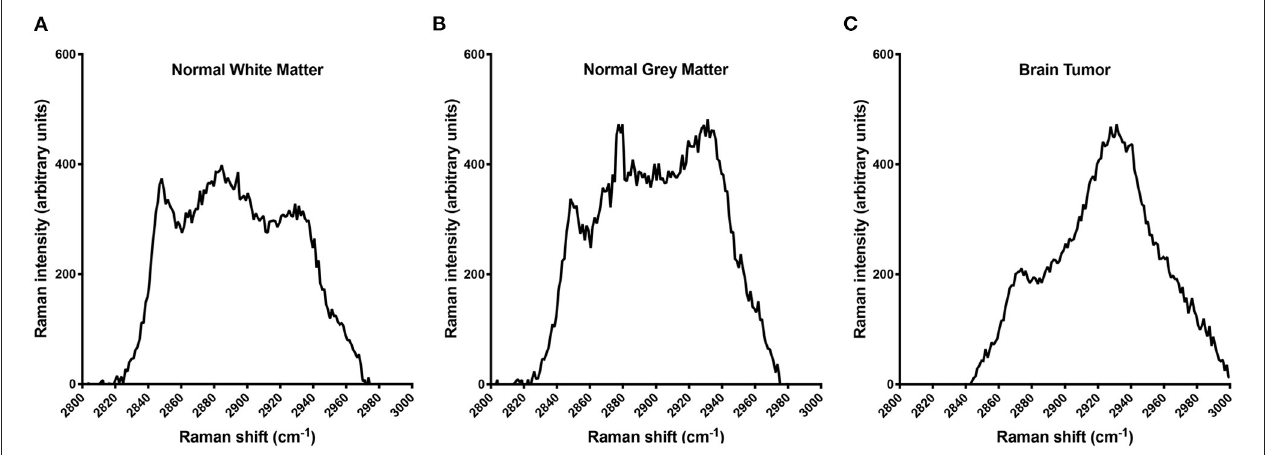
FIGURE 1 | Raman spectra illustrating the differences in the protein:lipid ratio among normal white matter (A) , normal gray matter (B) , and brain tumor (C) . The decreasing lipid content among white matter, gray matter, and tumor tissue accounts for this shift. In a clinical setting, all five readings are used individually to screen for a protein:lipid ratio indicative of tumor tissue; however, for illustrative purposes the data presented here are averages of the five interrogations for samples 2, 5, and 6, respectively.